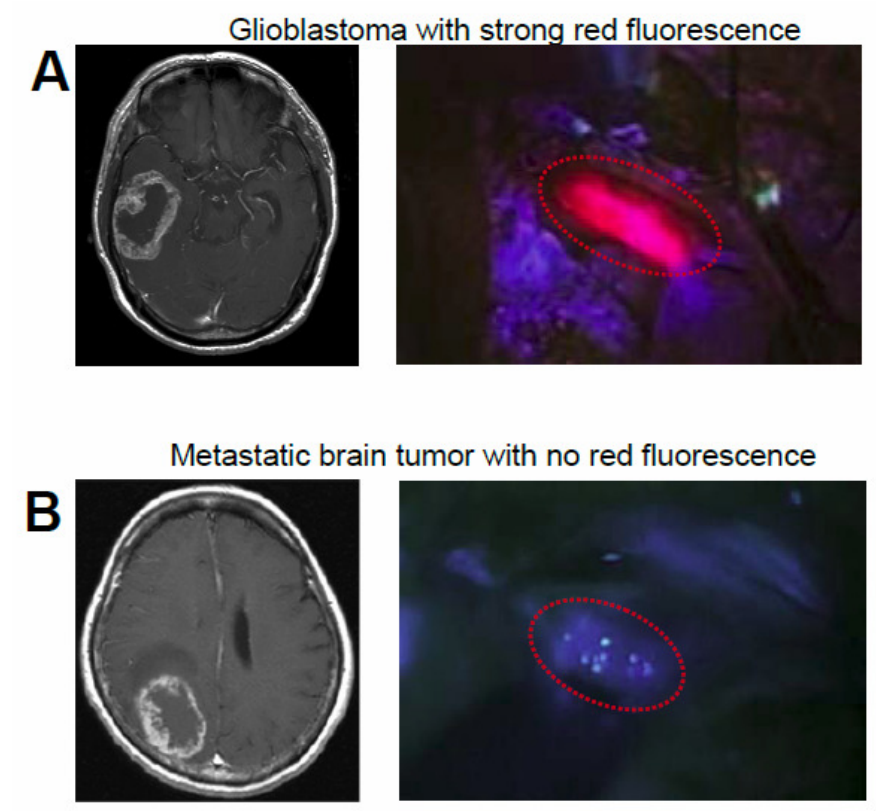
Figure 2. Preoperative Gd-enhanced MRI scanning and 5-ALA-induced tumor fluorescence. ( A ) Glioblastoma with strong red fluorescence; ( B ) metastatic brain tumor with no red fluorescence. Circular lines show the tumor location in operative view. Data are from reference